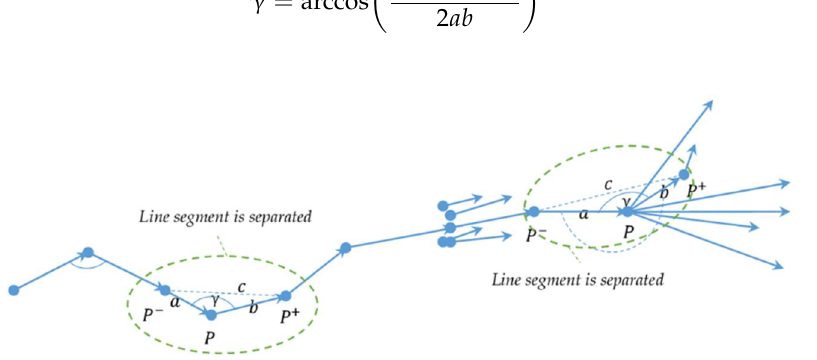
Figure 10. Illustration of intersection angle-based constraint.